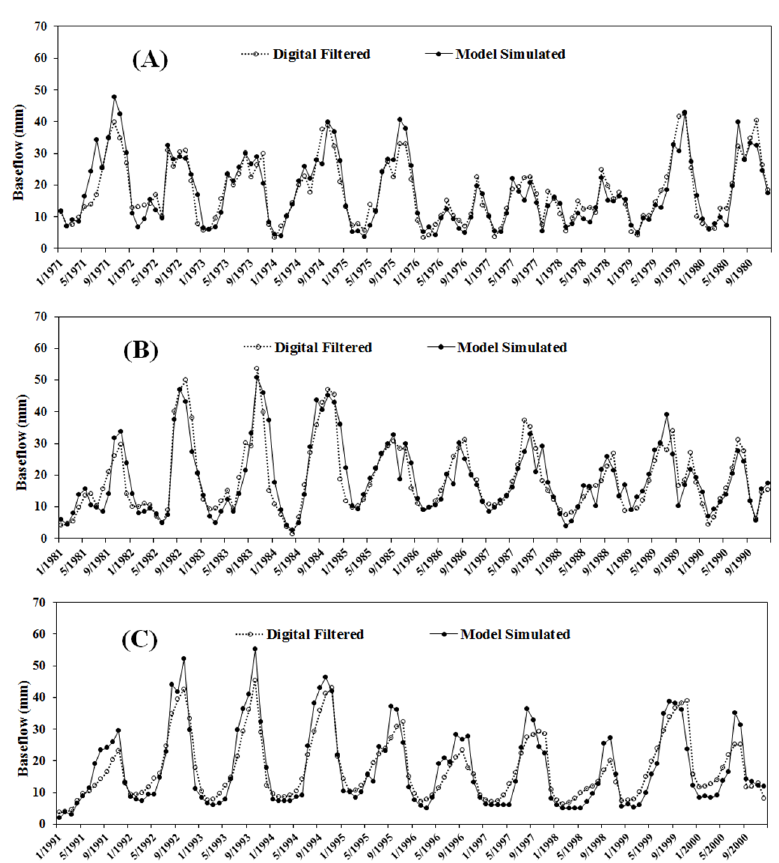
Figure 3. Monthly digital filtered ‐ based and model ‐ based baseflow in the Upper Du Watershed for the calibration (from 1 January 1971 to 31 December 1980) at Zhushan station ( A ); validation (from 1 January 1981 to 31 December 1990) at Zhushan station ( B ); and validation (from 1 January 1991 to 31 December 2000) in Xinzhou station ( C ).